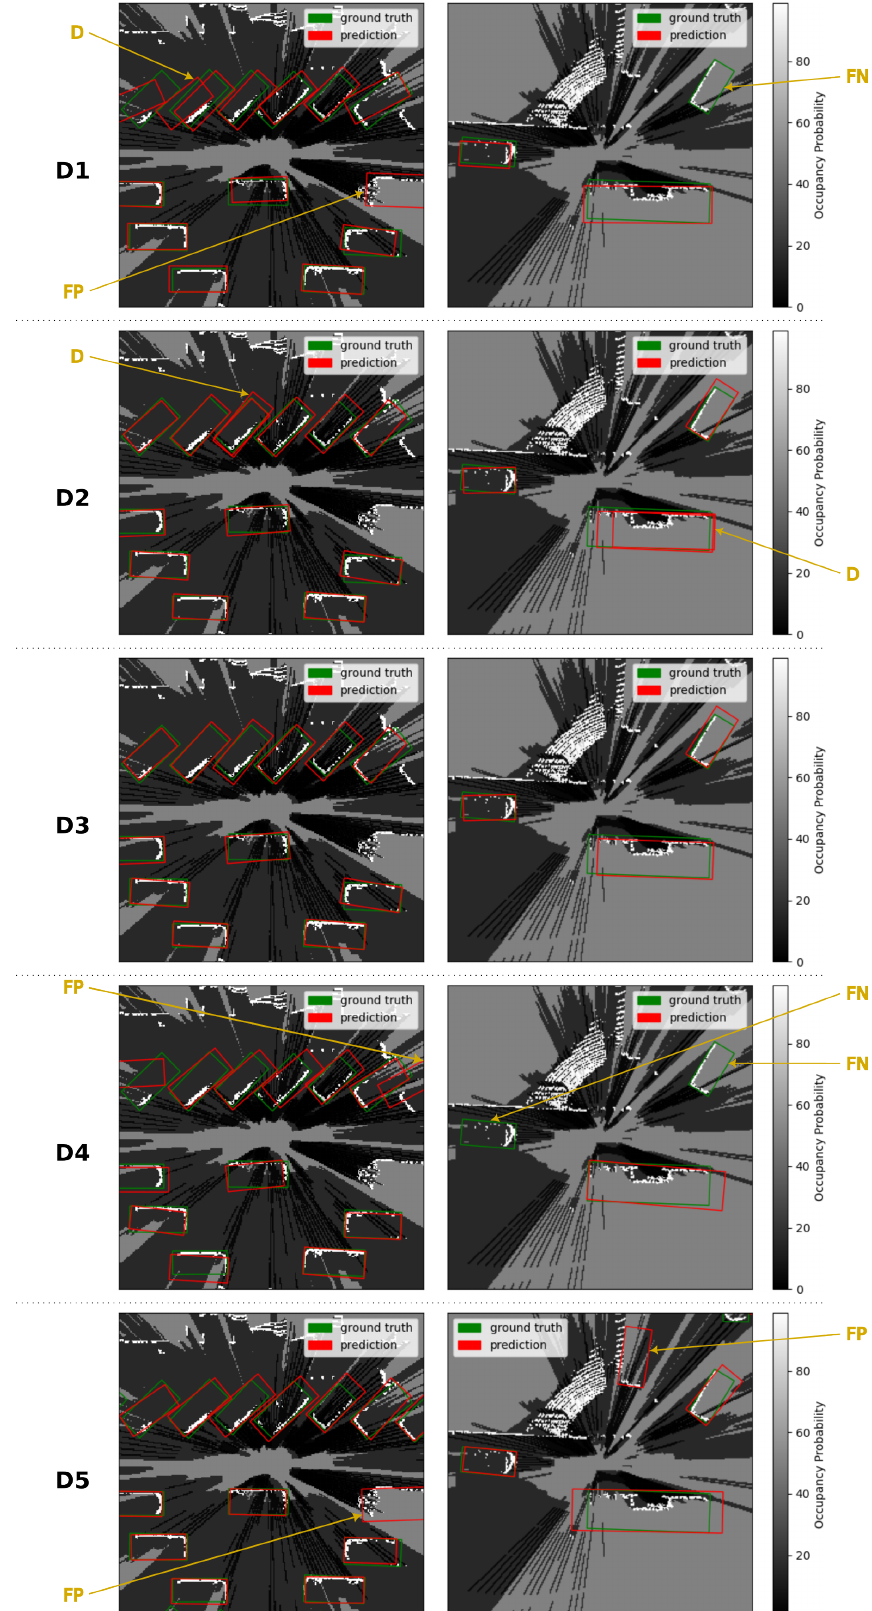
Figure 5. Examples of predictions. Occupancy probability is encoded in grayscale. False positive (FP), false negative (FN) and duplicate (D) detections are highlighted with golden